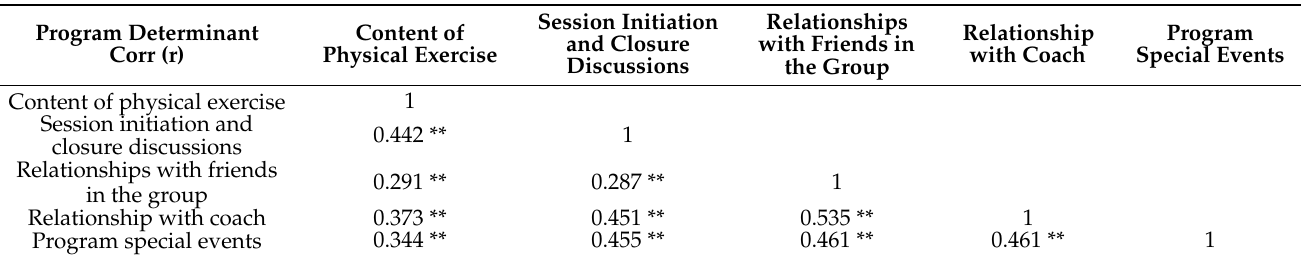
Table 4. Correlations between organized sports program components: content of physical exercise, session initiation and session closure discussions, relationships with friends in the group, relationship with the coach, and program special events. Program Determinant Corr (r)